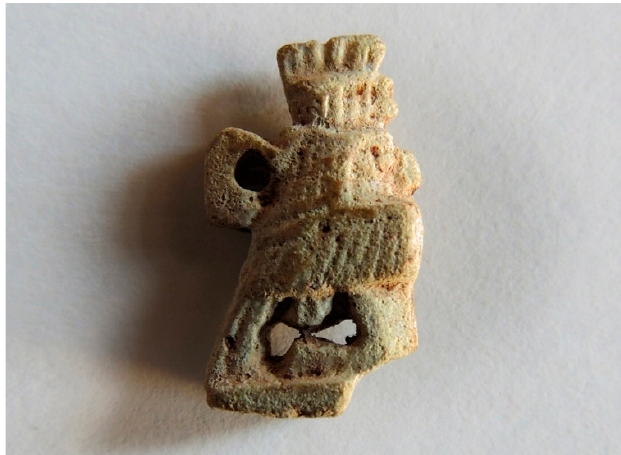
Figure 24. Horus-falcon figurine (MGW inv. no. 1865); faience amulet; ca. 4th century BCE (?).